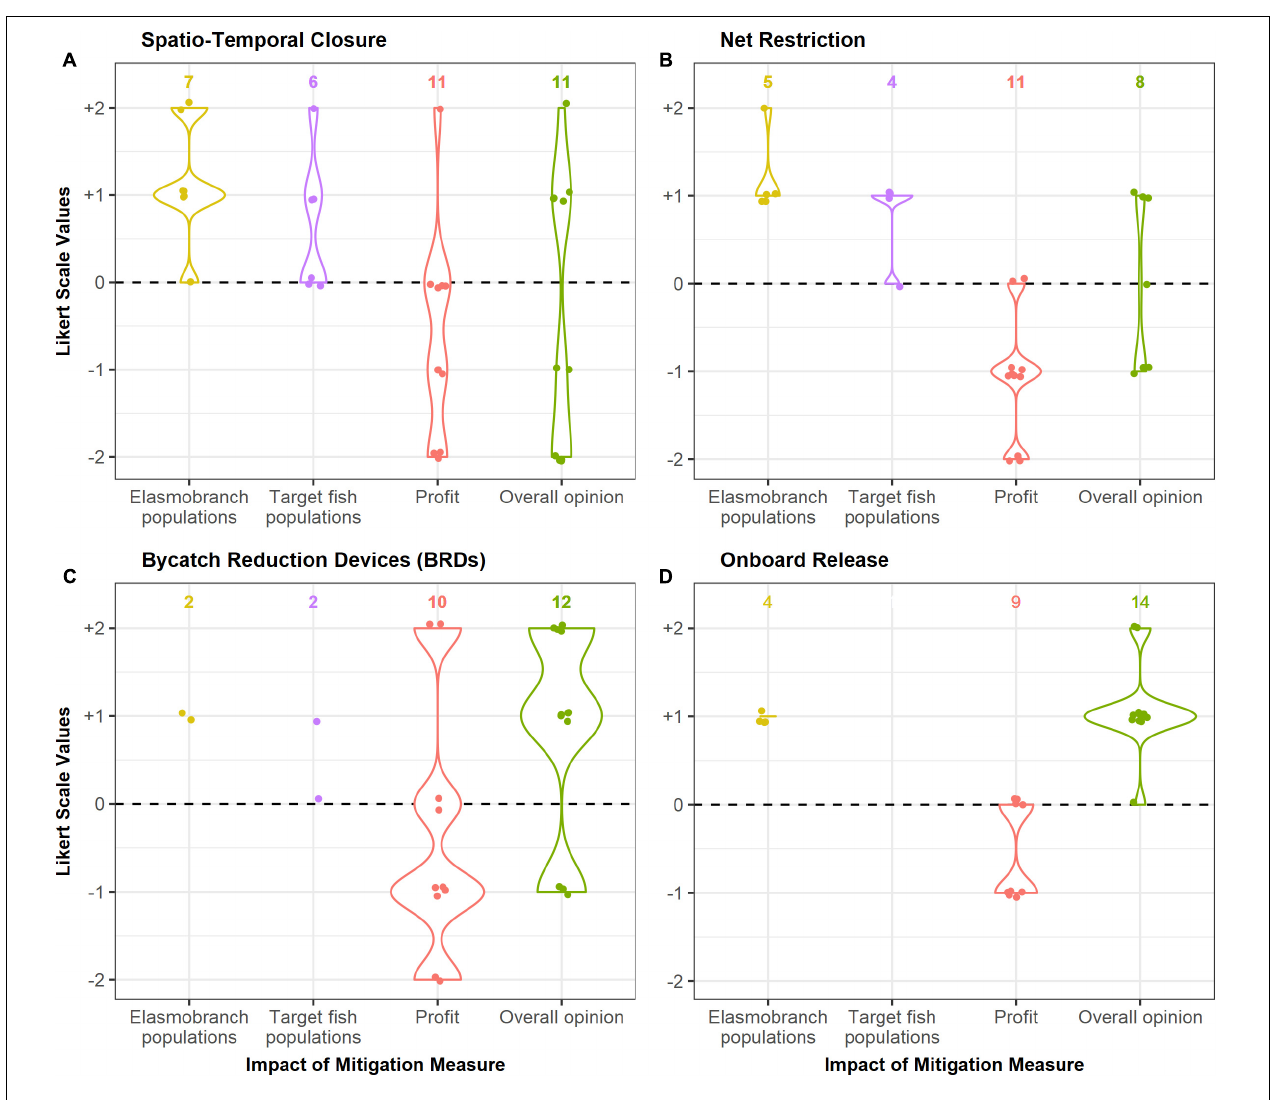
FIGURE 3 | Perceived impact of each mitigation measure (A–D) on elasmobranch populations, target species populations and profit of the boat owners, obtained through interviews. Data is represented on a five-point scale from –2 (greater than a 50% decrease) to +2 (greater than a 50% increase). The overall opinion of the respondents on each mitigation measure is also presented here on a similar scale (–2: Very negative opinion to +2: Very positive opinion). Sample size for each response is given above the plot. Questions on the impact of each measure on elasmobranch populations and target fish populations were directed to fishers (total sample size = 7), whereas questions on the impact on profits were directed toward boat owners (total sample size = 11). An overall opinion on the mitigation measure was asked to both fishers and owners. Not all respondents were able to provide answers for every question, hence the sample size represented on the graph may be lower than the total in some